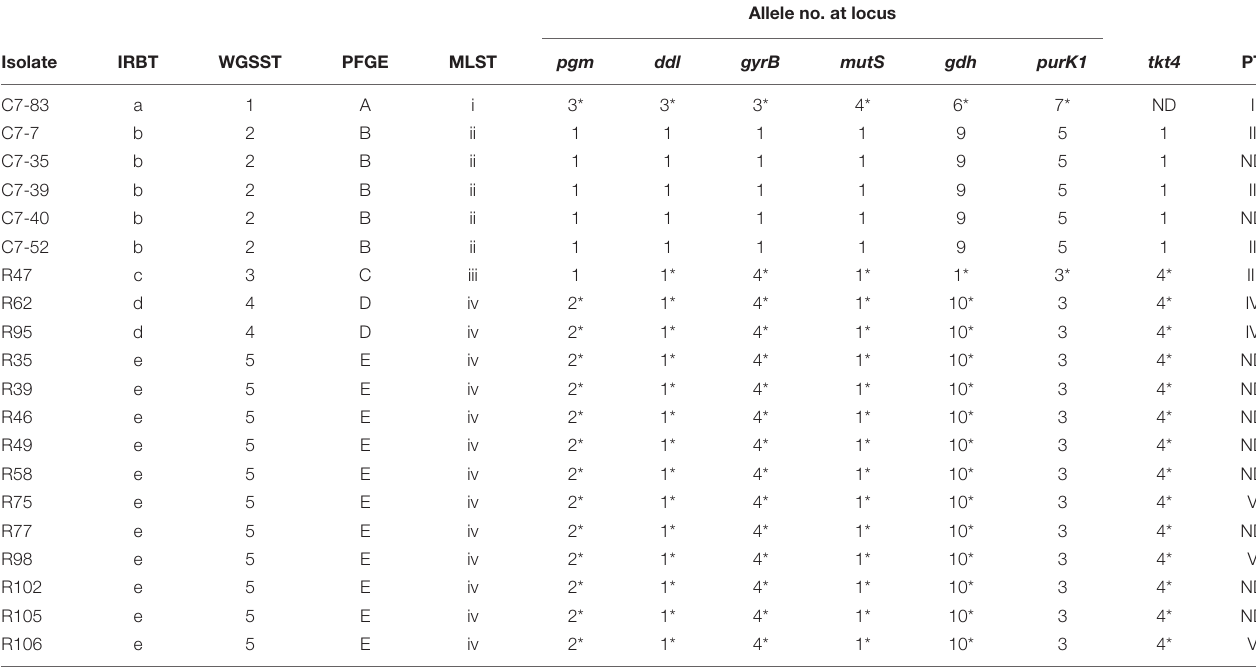
TABLE 2 | Comparison of IRBT spectroscopic typing with other genotypic and phenotypic typing results.